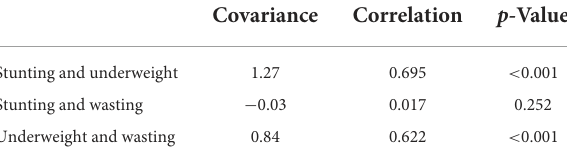
TABLE 3 Covariance and correlation between anthropometric